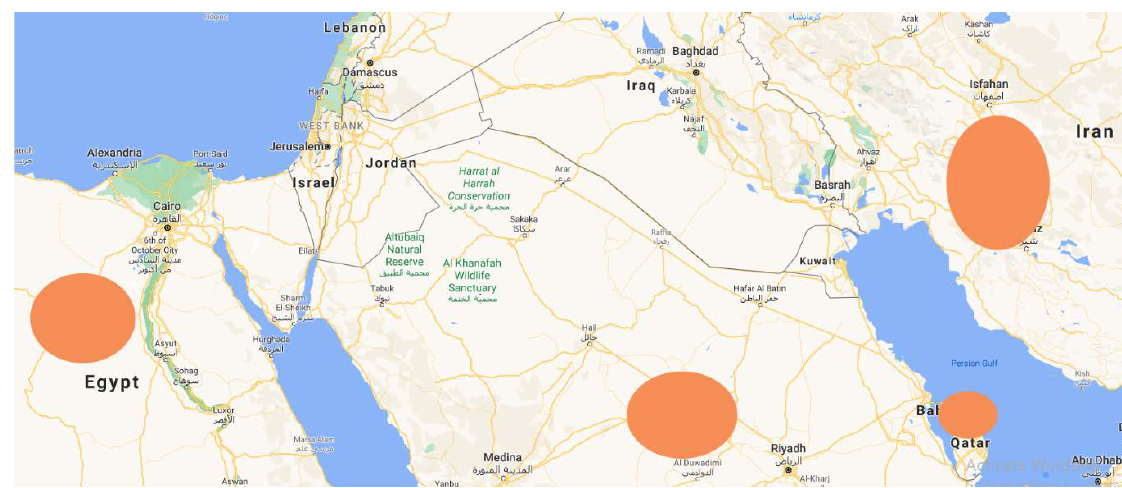
Figure 1. Locations of pigeon towers in Central Asia on Google map (source: